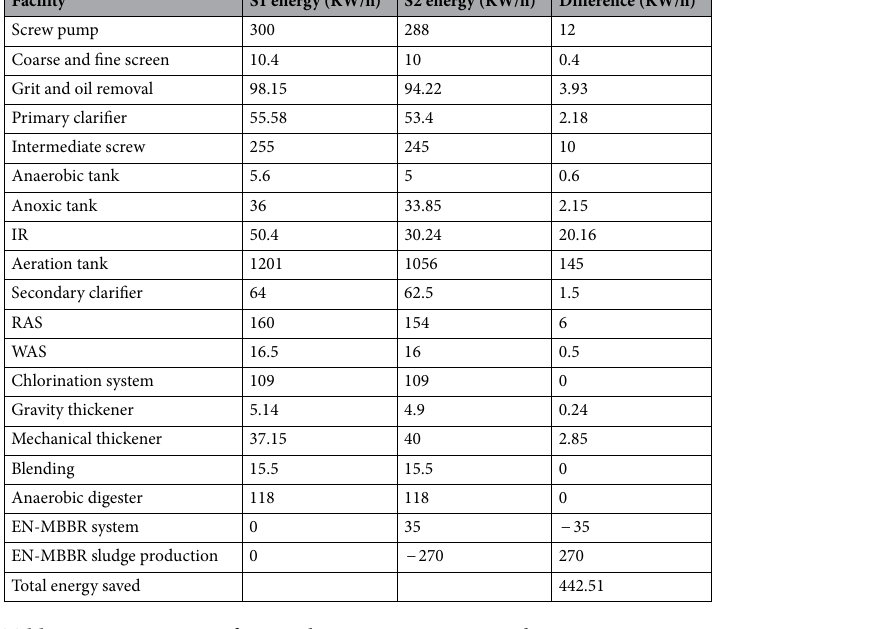
Table 10. Comparison of energy between Scenarios 1 and